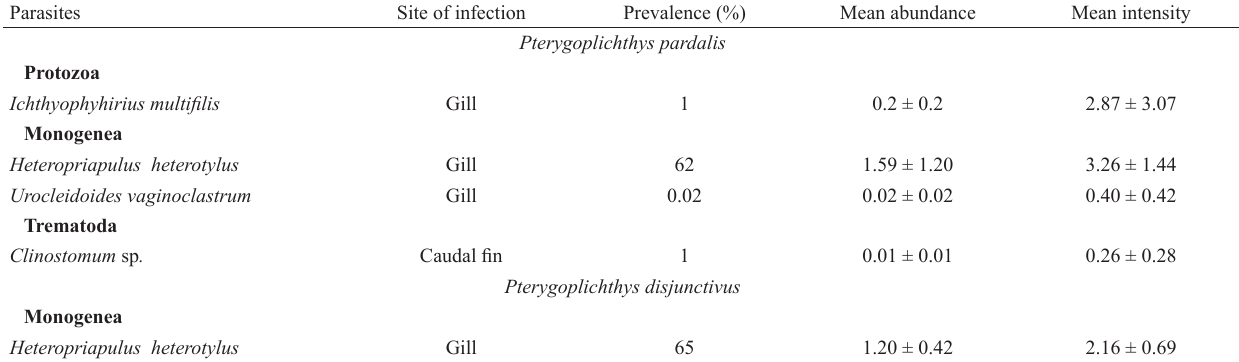
Table 1. Infection parameters of the parasite from Pterygoplichthys pardalis and P. disjunctivus.